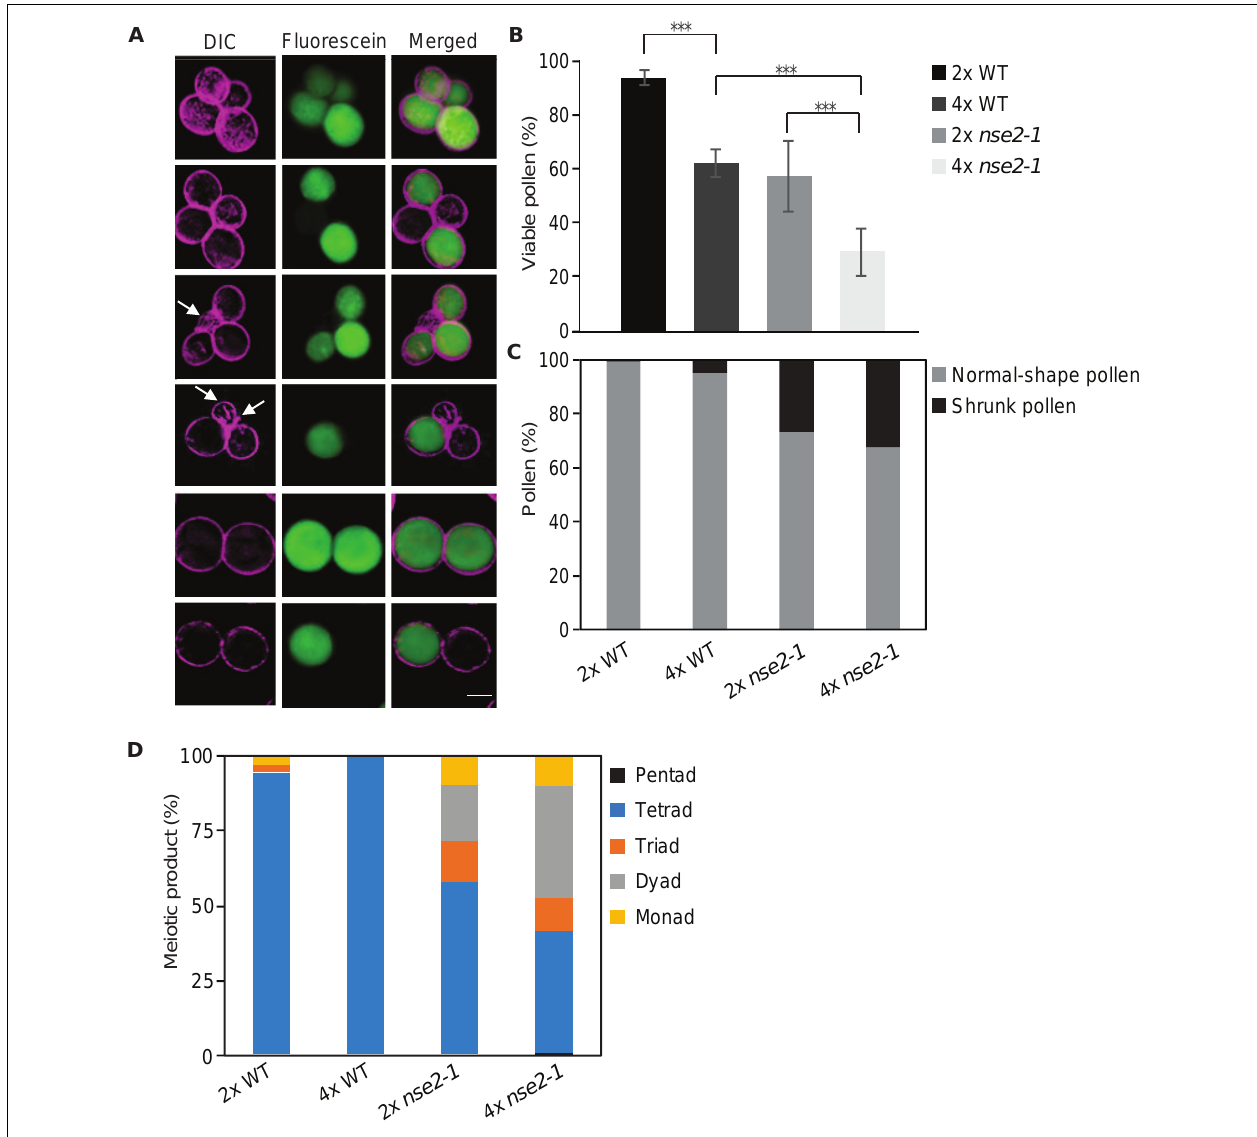
FIGURE 4 | Microspore phenotype of tetraploid (4x) nse2-1 plants. (A) Representative mature pollen stained by fluorescein diacetate from 4x nse2-1 qrt1-4 plants. Differential interference contrast (DIC) images were pseudocolored in violet. Viable microspores are indicated by fluorescein signals (green). Shrunk microspores are indicated by arrows. Scale bar = 20 µ m. (B) Frequencies of viable pollen from 2x WT, 4x WT, 2x nse2-1 , and 4x nse2-1 (all in qrt1-4 background). Error bars represent standard deviations among the means of two or three individual plants. Significance in Fisher’s exact test: − = P > 0.05 , * = P < 0.05, ** = P < 0.01 , and *** = P < 0.001 . Source values and basic counts are provided in Supplementary Table 3 . (C) Quantification of normal-shape and shrunken pollen observed in 2x WT, 4x WT, 2x nse2-1 , and 4x nse2-1 in qrt1-4 background. (D) Quantification of meiotic products with different numbers of microspores as observed in 2x WT, 4x WT, 2x nse2-1 , and 4x nse2-1 in qrt1-4